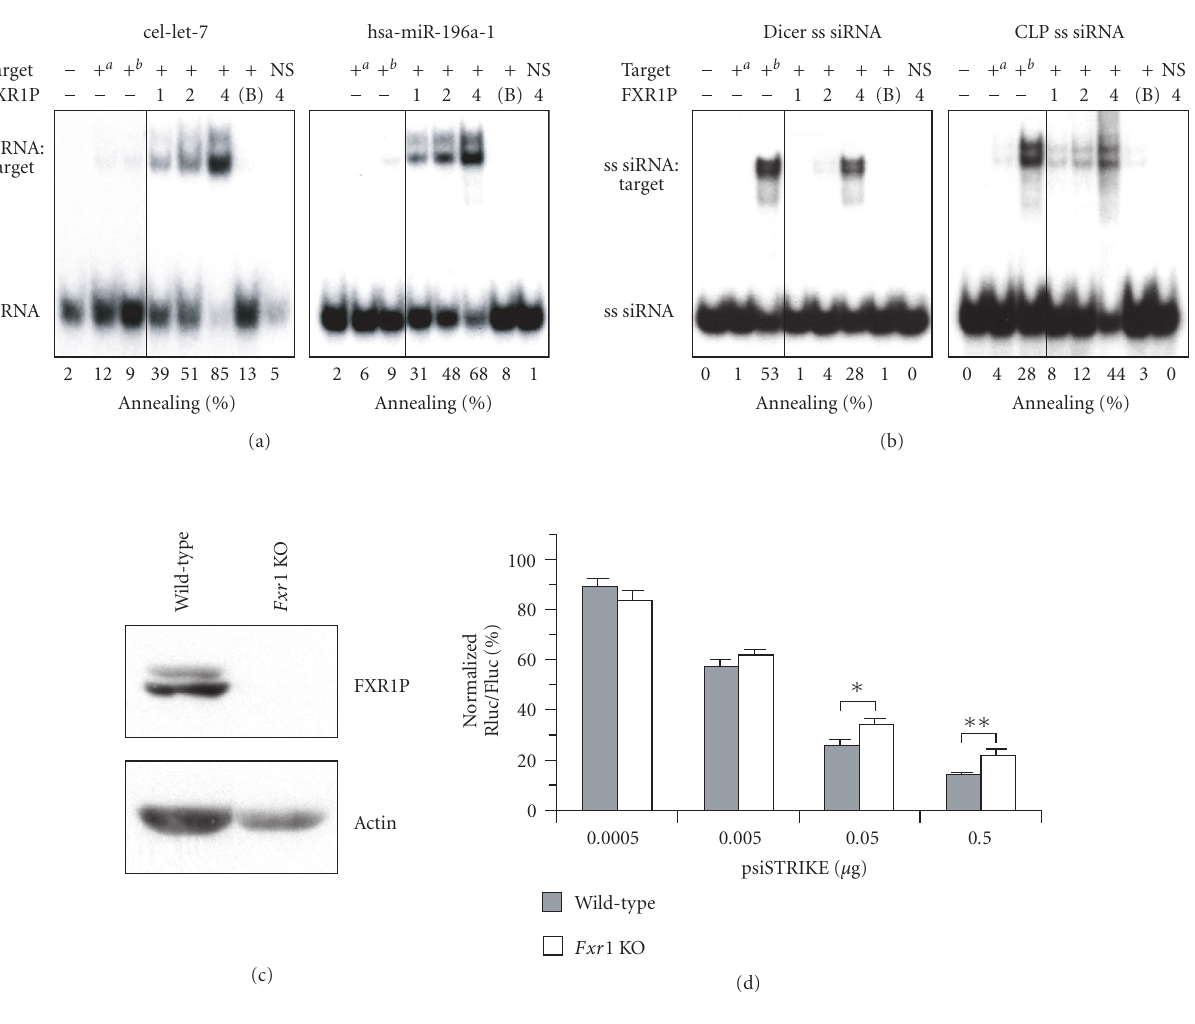
Figure 6: The paralog FXR1P shares the RNA strand annealing properties of FMRP. (a)-(b) RNA strand annealing assays with FXR1P were performed and analyzed as described in the legend of Figure 2. (c) Expression of FXR1P in wild-type and Fxr1 KO cells was verified by immunoblot analysis, in parallel with actin. (D) Fxr1 KO and wild-type (Na¨ıves) cells were cotransfected with psiSTRIKE encoding Rluc shRNA and psiCHECK reporter construct ( n = 6). Results were expressed as mean ± SEM and analyzed as described in the legend of Figure 4. ∗ P < . 05; ∗∗ P < .